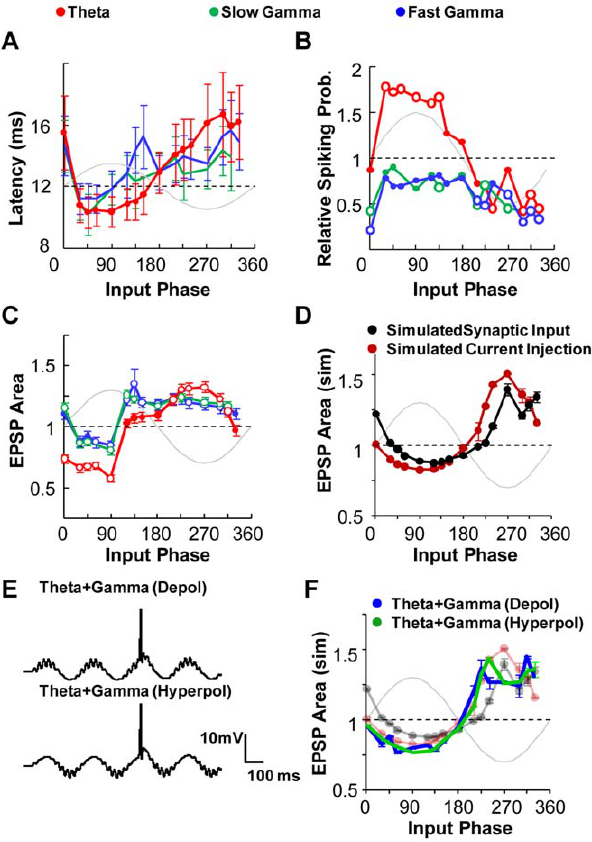
Figure 4. Rhythmic Input Shapes Response to Synaptic Input. Mean response of hippocampal CA1 cells to synaptic input arriving at 16 different phases of the injected sine wave. Sine waves of 3 frequencies were injected (Red: theta; Green: slow gamma, Blue: fast gamma). The dotted line parallel to the x-axis represents the control case with no background current injection and the sinusoidal gray trace shows the somatic current injected at the input phases. Open symbols represent significant data points (in comparison with the control group). Error bars represent SE. ( A ) Latency of spiking is a function of the phase with both theta and gamma frequency background. The cell spikes earlier in the depolarizing phase of sinusoidal current injection. This effect is more pronounced for theta frequency current injection but does not cross the significance criterion of p , 0.05. ( B ) The probability of spiking following synaptic input is significantly higher between 30– 135 degrees input phase with theta current injection. The probability of spiking is below the control for all values of input phase with slow and fast gamma frequency current injection. Data points that are significantly higher or lower (Binomial Test, p , 0.05) than control are represented as open symbols. ( C ) Subtracted EPSP area is a function of both the phase of synaptic input and frequency of current injected. Area is normalized to control responses with no background current. The background sine wave injected is centered on zero current. The best fit sinusoid to the cell’s response was subtracted from the EPSP trace. Data points that are significantly higher or lower (Student’s t-test, p , 0.05) than control are represented as open symbols. ( D ) Somatic current injection and network activity generated using a barrage of done using an in silico model of CA3-CA1 network. The phasic modulation is qualitatively similar to responses measured in whole-cell recording experiments. ( E ) Theta-gamma coupled inputs paired with afferent inputs were simulated using the current injection protocol. Two types of input were given – one, with the maximal power of gamma frequency input aligned with the depolarized phase of theta input (above). Two, the maximal power of gamma input coincided with the hyperpolarized phase of theta input (below). ( F ) The phasic